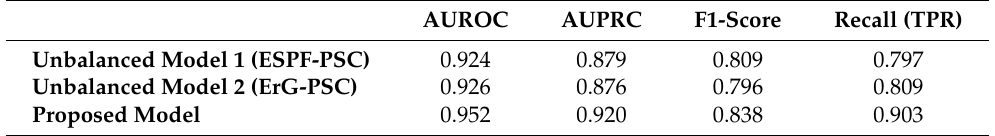
Figure 3. Receiver operating characteristic curve yielded for two unbalanced models and our proposed method on the BindingDB dataset. Table 5. Comparison of the computational results yielded for two unbalanced models and our proposed method on the BindingDB